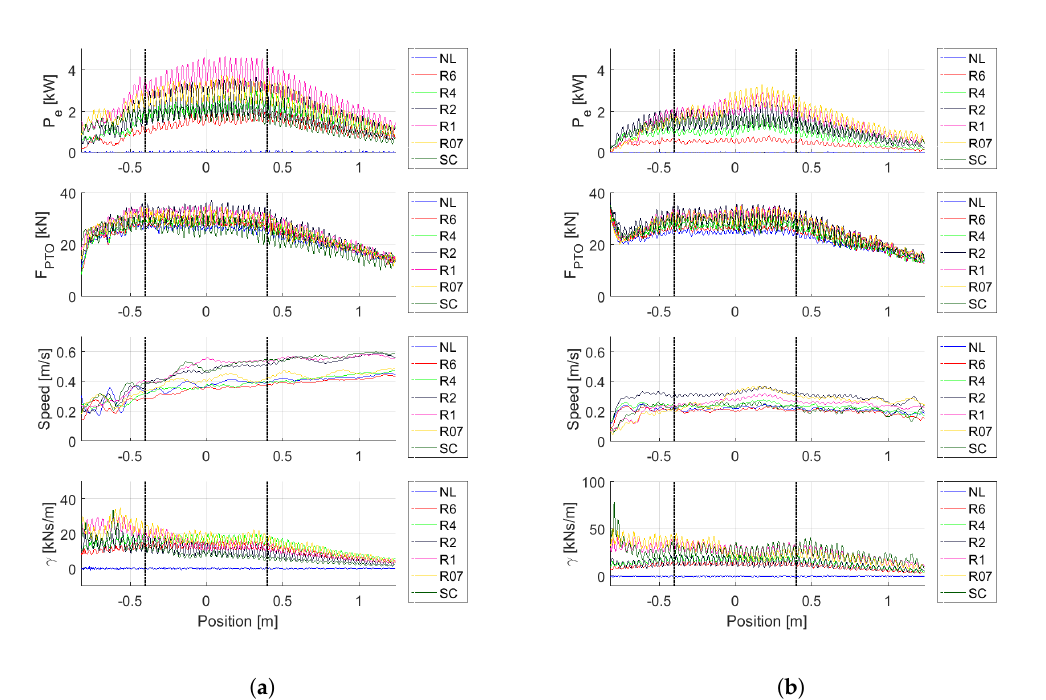
Figure 7. Electrical power and damping force as well as speed and damping coefficient for seven cases when the translator is moving upward ( a ) and for seven cases when the translator is moving downward ( b ). Dotted black lines mark beginning and end of full stator overlap, i.e., A frac = 1 inside the dotted black lines. In the legends, NL stands for No Load; R6 stands for load 6.6 Ω ; R4 stands for load 4.4 Ω ; R2 stands for load 2.2 Ω ; R1 stands for load 1.1 Ω ; R07 stands for load 0.73 Ω ; SC stands for Short